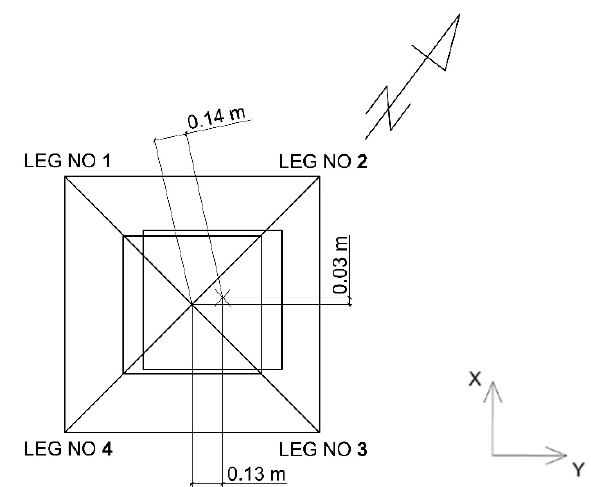
Figure 10. Tower A rotation and translation.